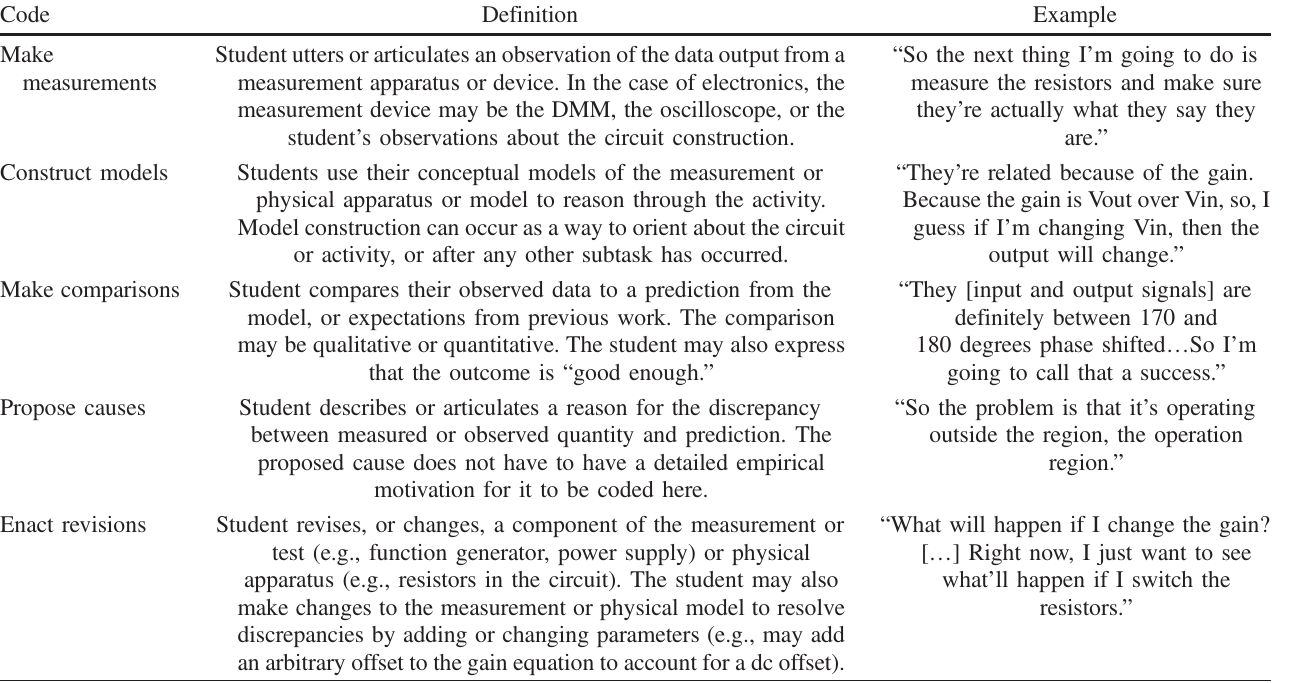
TABLE II. A priori coding scheme and examples from different student